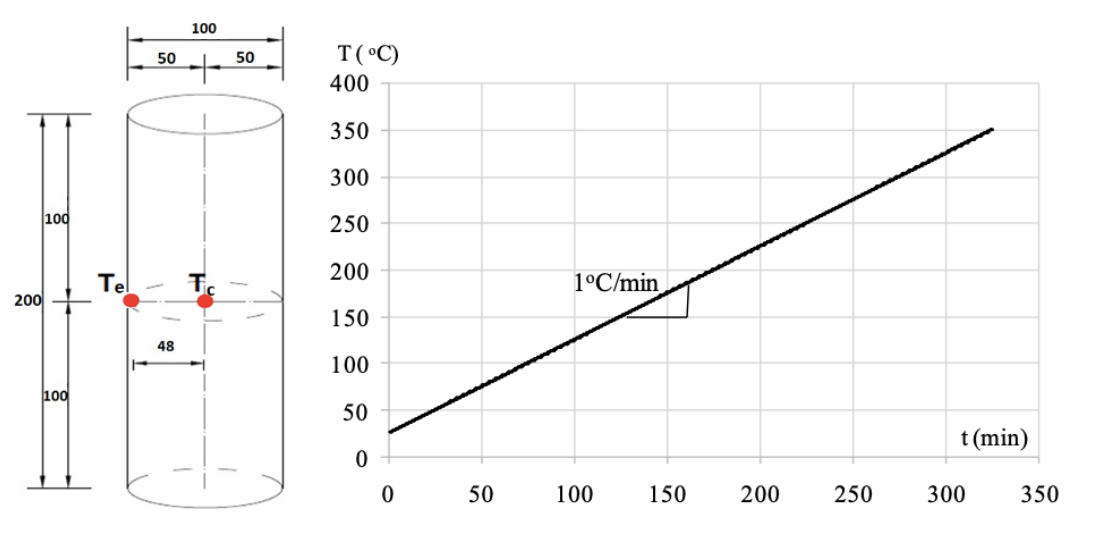
Figure 1. Thermocouples arrangement in the concrete cylinder, and the furnace heating